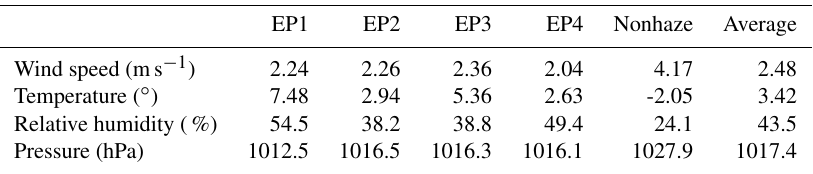
Figure 3. Source contribution of PM 2 . 5 (a) in the whole sampling period and (b) in different pollution episodes and nonhaze periods (yellow for dust source, green for biomass burning, pink for industrial source, red for coal combustion, black for traffic sources and blue for secondary sources). Dates are mm/dd. Table 1. Meteorological conditions during pollution episodes and nonhaze